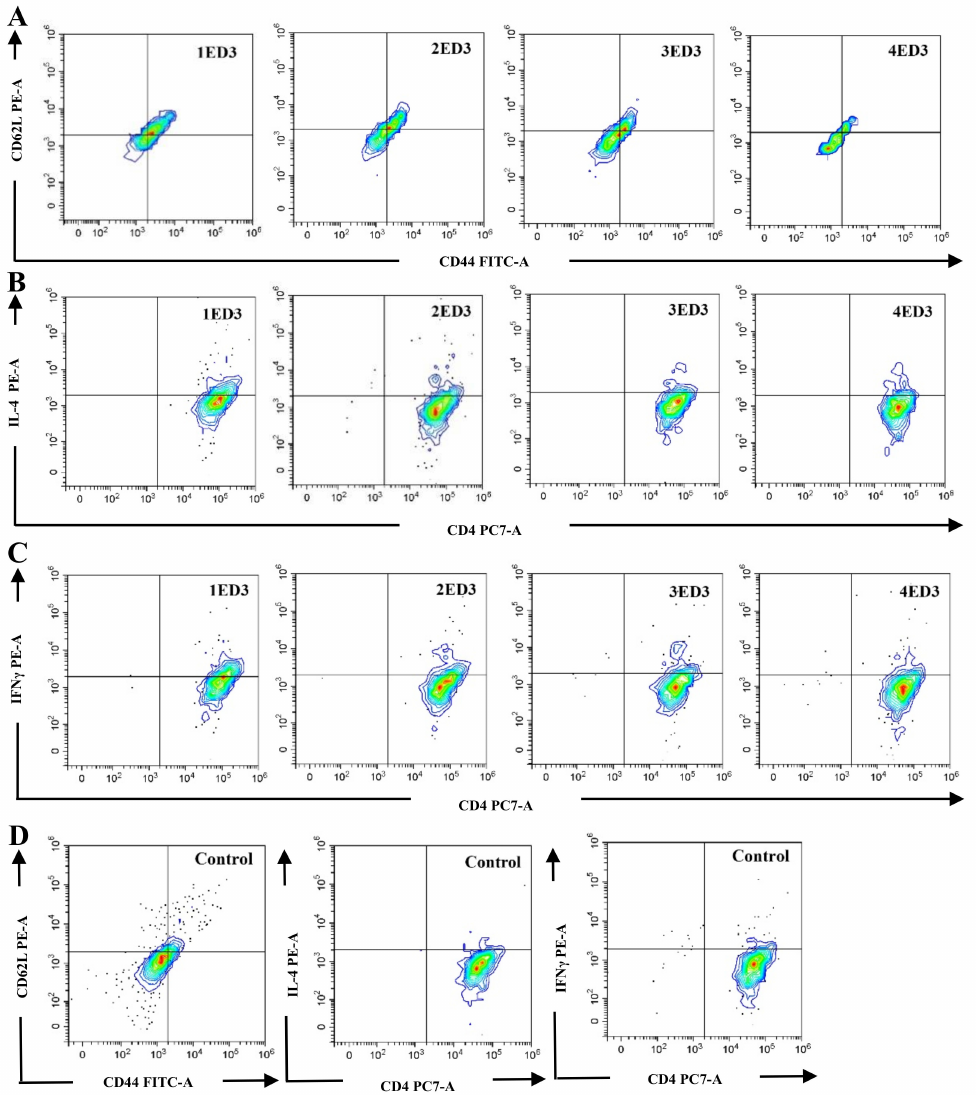
Figure 4. Effects of ED3 immunization on T-cell memory status in BALB/c mice. The CD44-CD62L co-expression at day 14 ( A ), IL-4 expression at day 7 ( B ), and IFN- γ expression at day 7 ( C ) by T H cells are shown. Expression of CD44/CD62L, IL-4, and IFN- γ in unimmunized control mice ( D